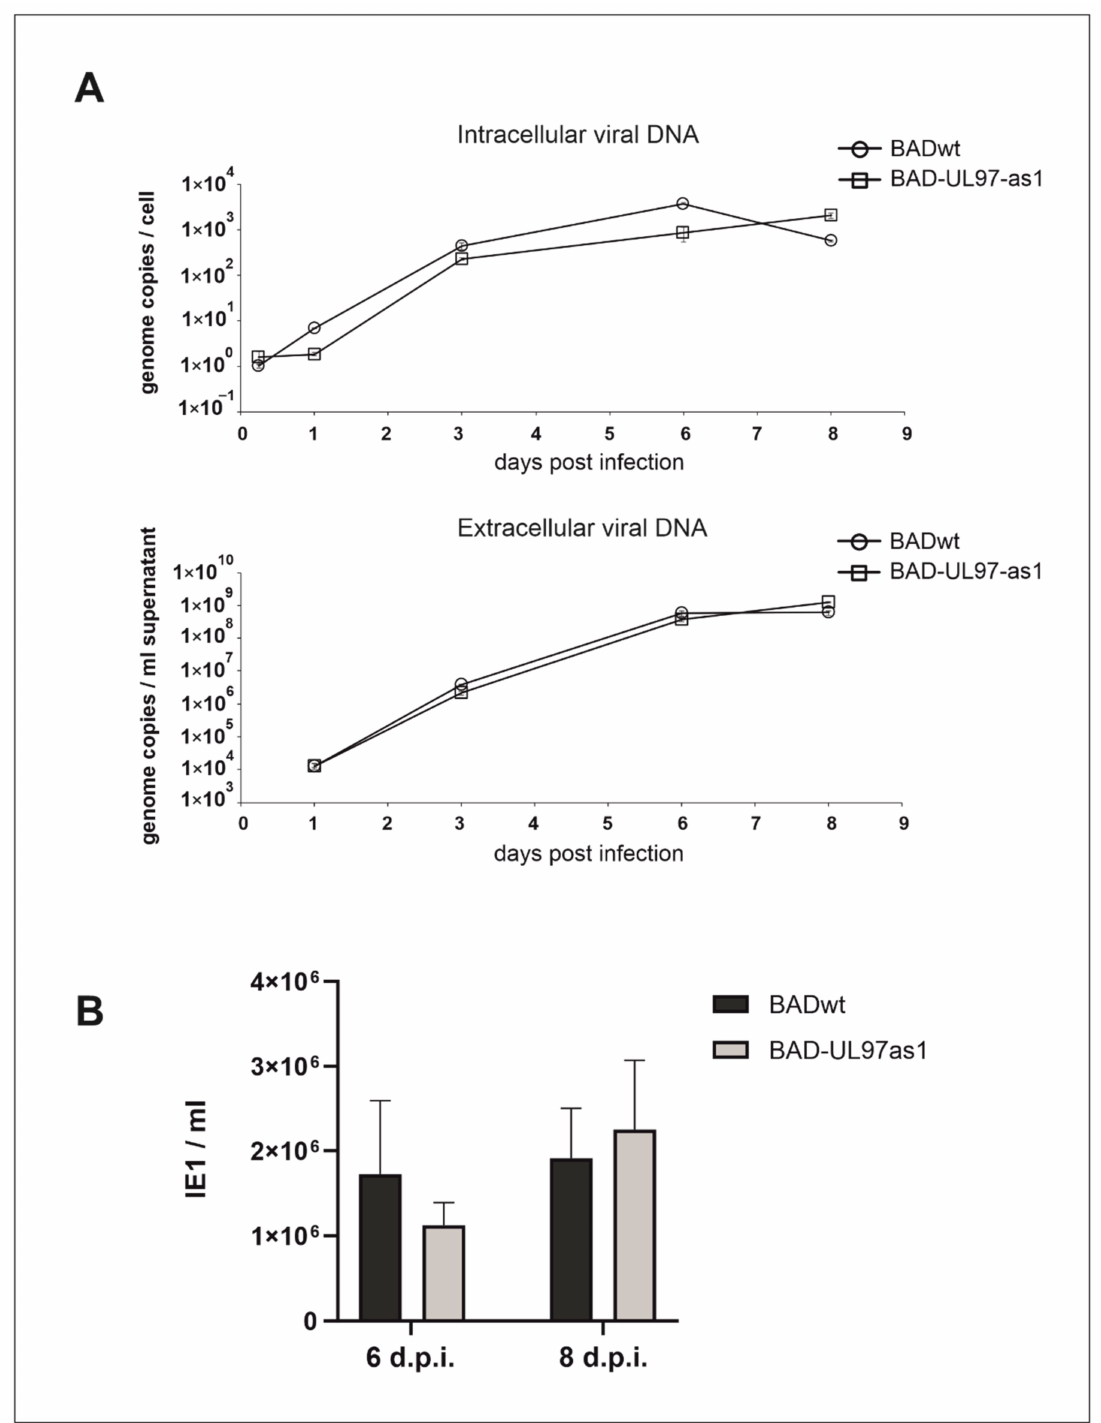
Figure 2. Replication kinetics of BADwt and BAD-UL97-as1. ( A ) Cells were infected with BADwt or BAD-UL97-as1 with 4 genomes/cell. Samples were taken and viral DNA was extracted from infected cells and the cell supernatant at the indicated time points. The intracellular and extracellular viral genome copies were quantified by quantitative PCR analysis. ( B ) HFF were infected with 4 genomes per cell with either BADwt or BAD-UL97-as1. After 6 and 8 days post infection, supernatants were collected and used to analyze the level of viral infectivity by serial dilution on indicator cell cultures, using staining for the immediate-early protein 1 (IE1) of HCMV at two days after inoculation. Bars represent the mean of eight technical replicates and the standard deviation is indicated by error